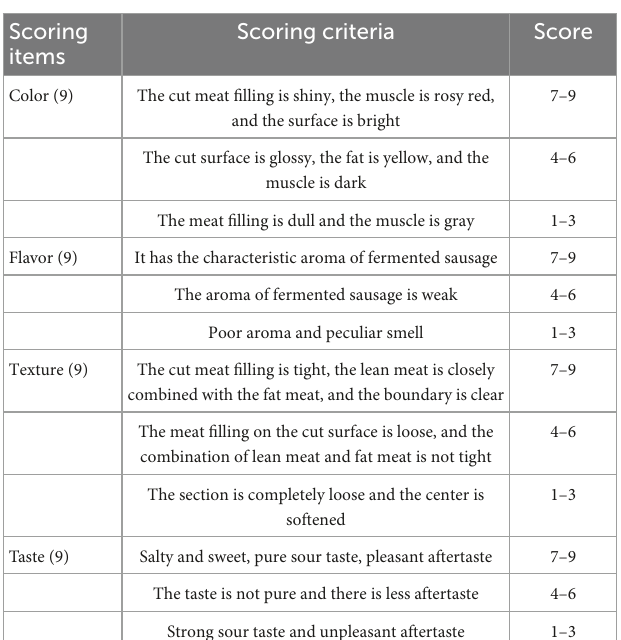
TABLE 1 The definition of sensory quality attributes for fermented